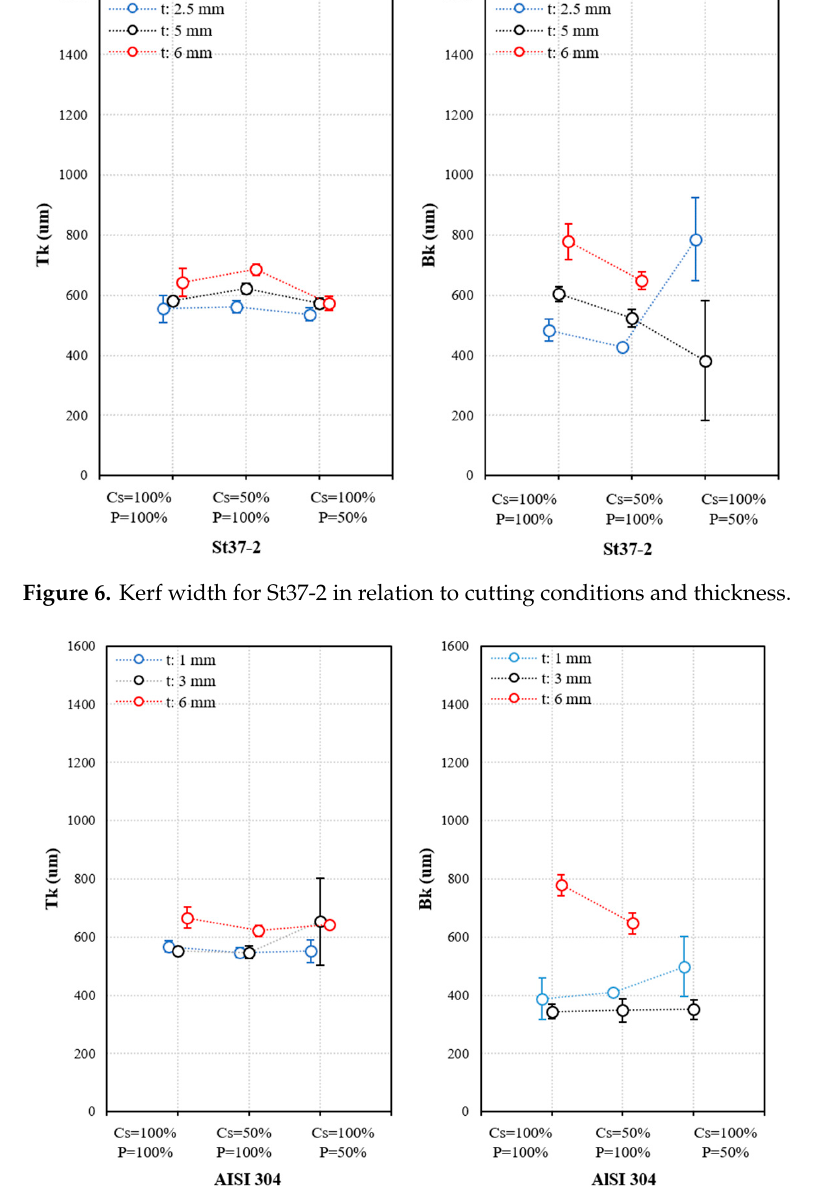
Figure 7. Kerf width for AISI 304 in relation to cutting conditions and thickness.